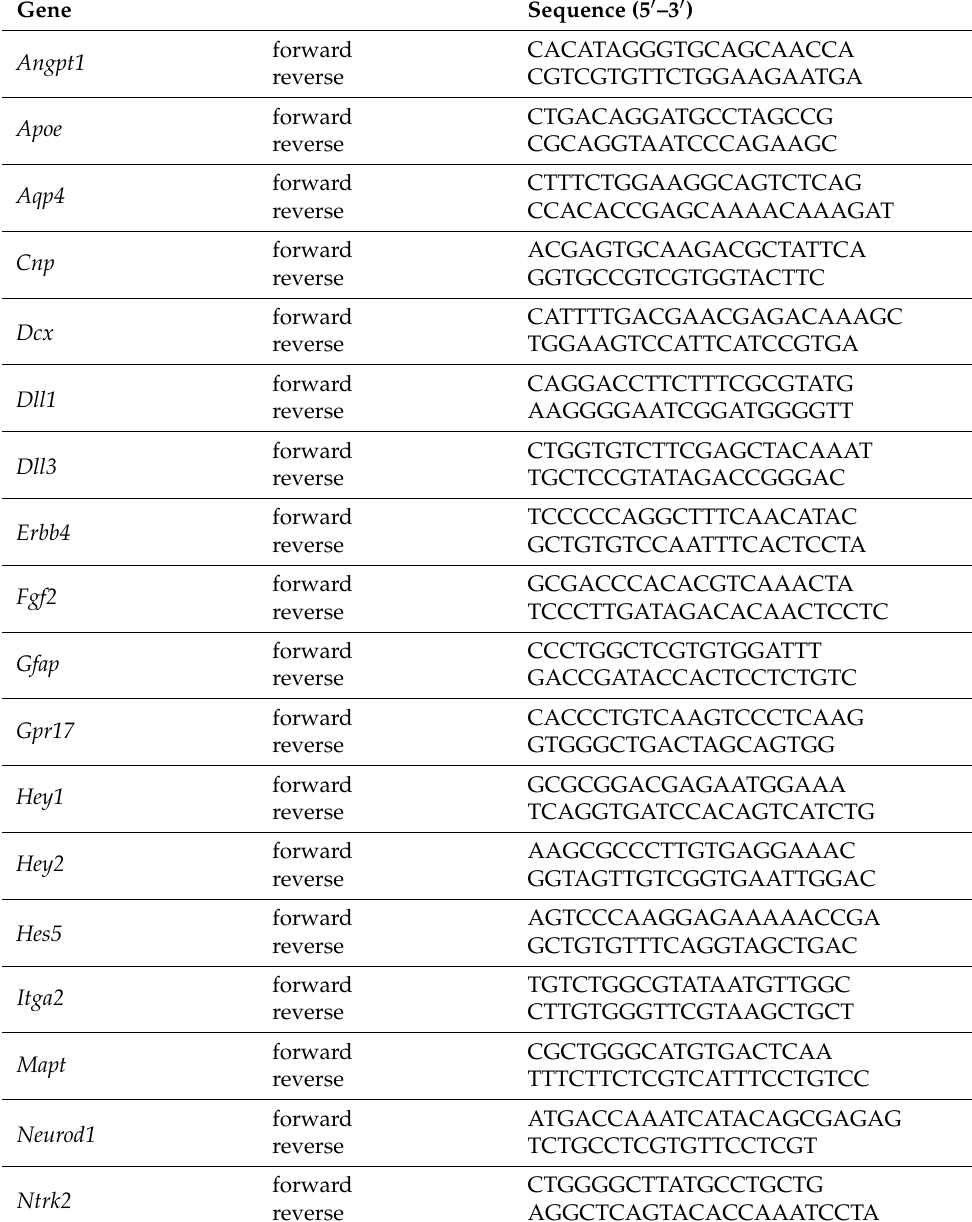
Table 1. The primers for